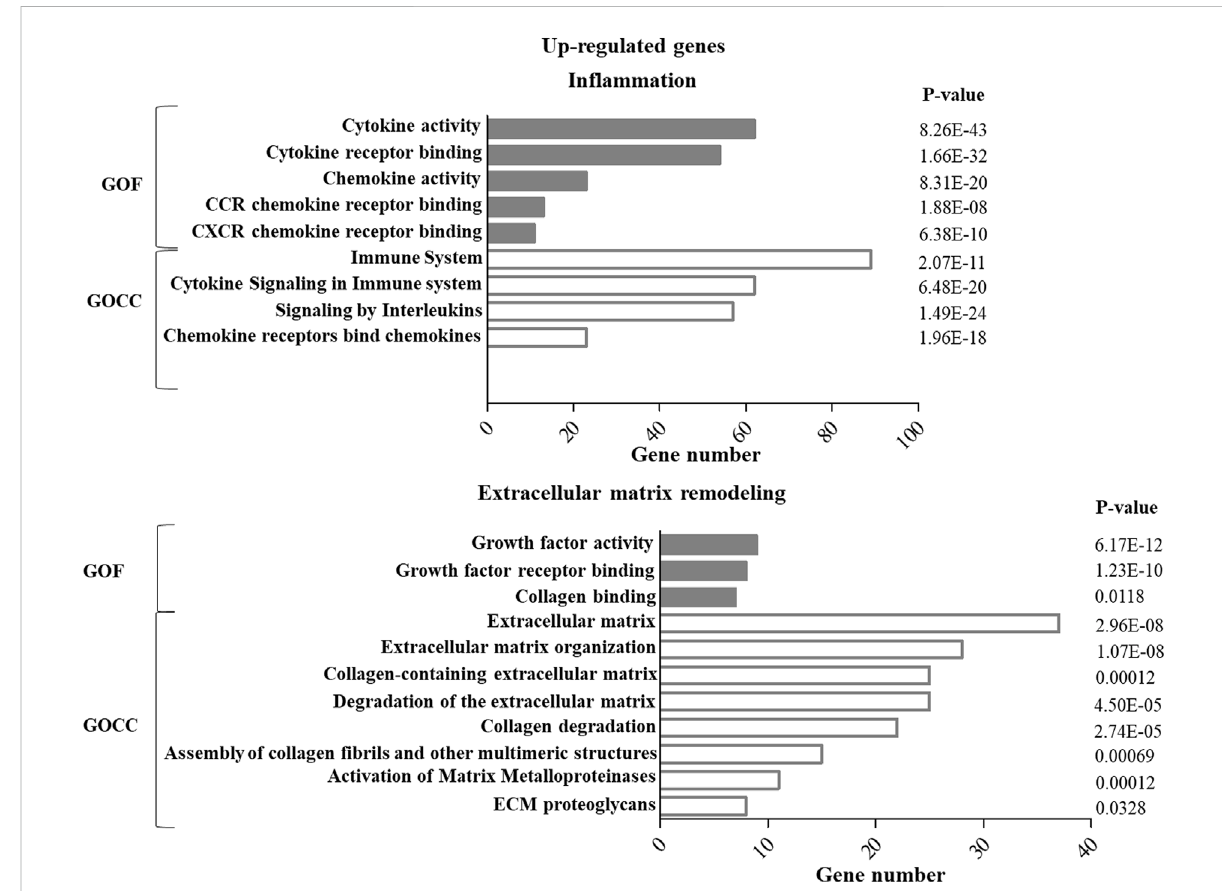
FIGURE 1 GOenrichmentanalysisofup-regulatedgenesinASCsafterIL-1 β priming.Up-regulatedgeneswereanalyzedusingtheGOfunction(GOF)and cellular component (GOCC) collections. A GO term was signi fi cantly enriched if p -value ≤ 0.05 and FDR ≤ 0.05. Genes could be comprised in more than one term depending on the function of the encoded protein. The graph shows the most relevant GO terms. The GO term name is reported on the y -axis; the number of enriched genes for each term is indicated on the x -axis. GO terms are listed by decreasing number of genes. The p value for each GO term is